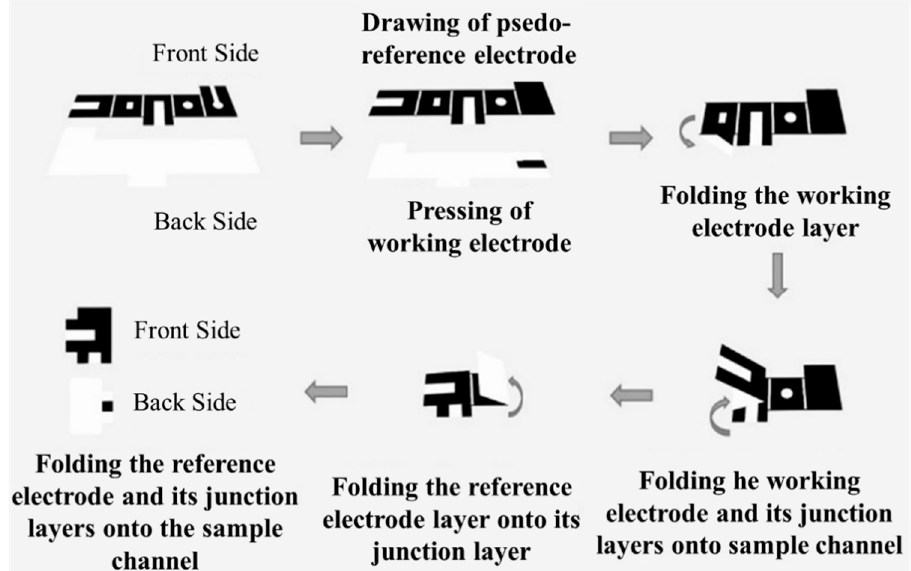
Scheme 1. Schematic representation of the folding processes for a three-dimensional origami paper-based potentiometric device.